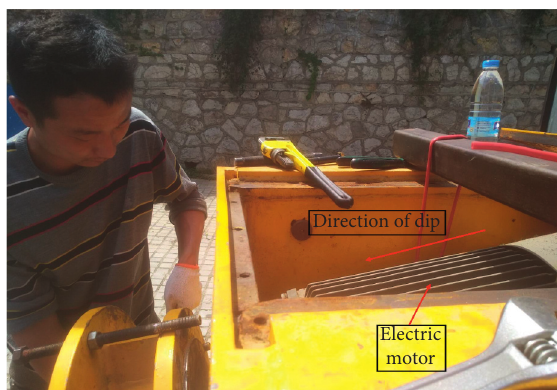
Figure 14: Motor mounting